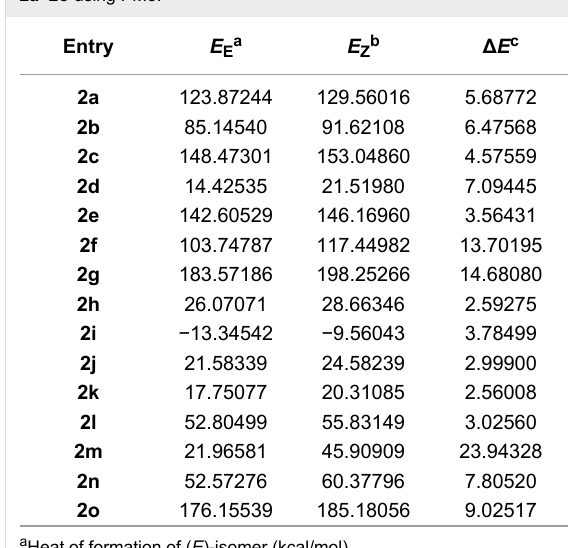
Table 2: Calculated heat of formation of synthesized hydrazones 2a – 2o using